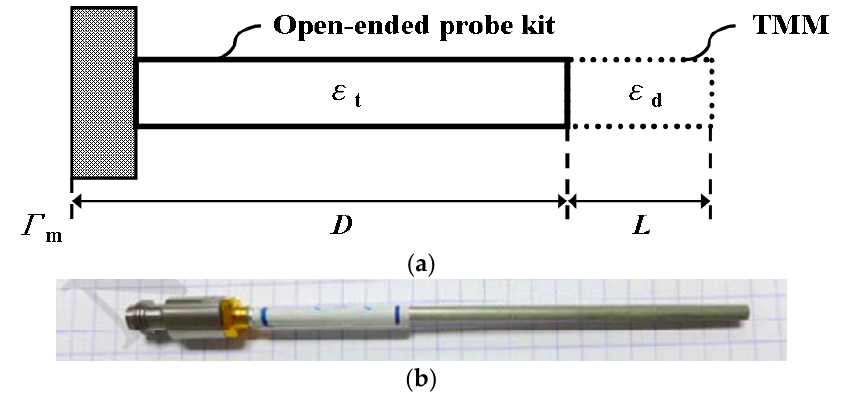
Figure 3. ( a ) The equivalent structure and ( b ) practical structure of the coaxial open-ended reflection probe.